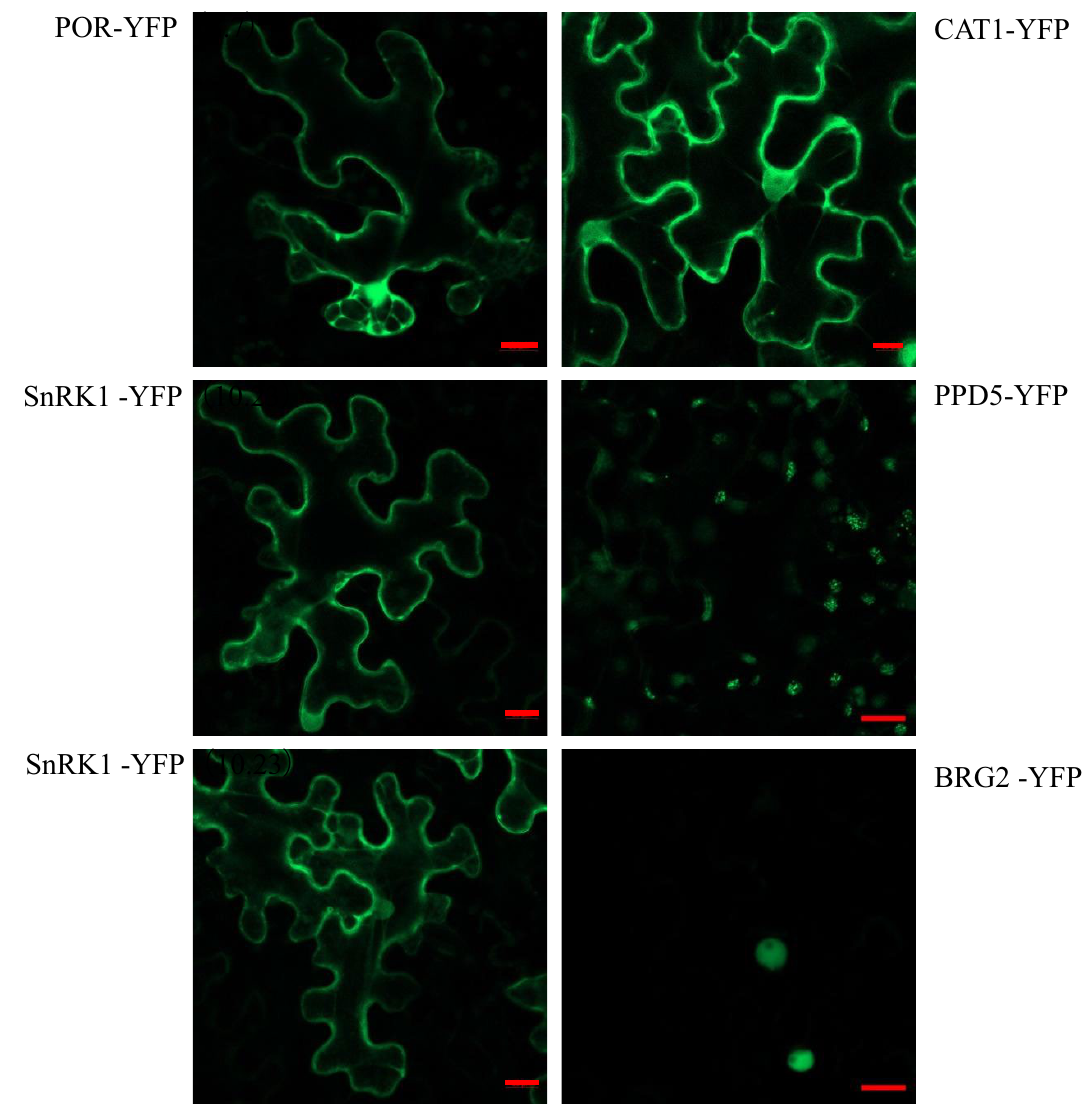
Figure 6. Subcellular localization of six 17K-interacting host proteins in N. benthamiana epidermal cells. YFP-tagged POR (POR-YFP), YFP-tagged SnRK1 (SnRK1-YFP), YFP-tagged SnRK2 (SnRK-YFP), YFP-tagged CAT1 (CAT1-YFP), YFP-tagged PPD5 (PPD5-YFP), and YFP-tagged BRG2 (BRG2-YFP) were expressed in N. benthamiana leaves through agrobacterium-mediated transient expression system. Confocal images were taken at 2 dpi using a ZeissLSM710 laser scanning microscope. The bar represents 20 μm.